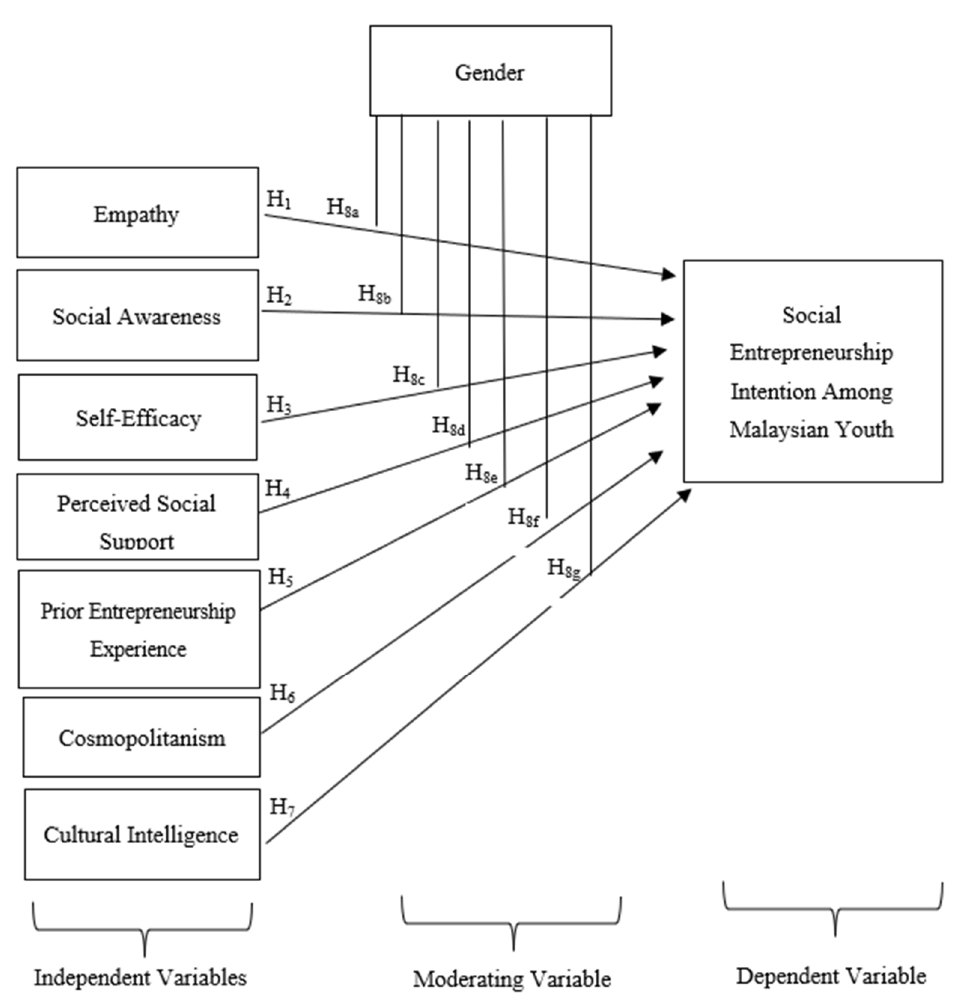
Figure 1. Research Figure 1 . Research framework .